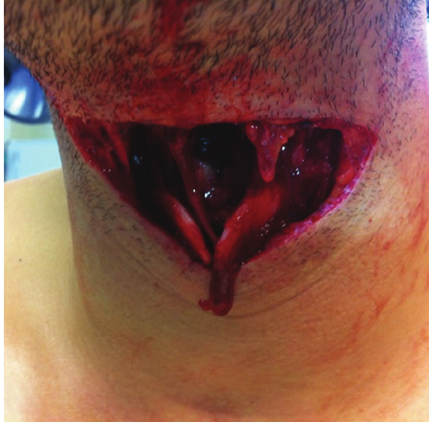
Figure 1: The laryngeal injury which was obvious at the time of initial presentation is demonstrated.